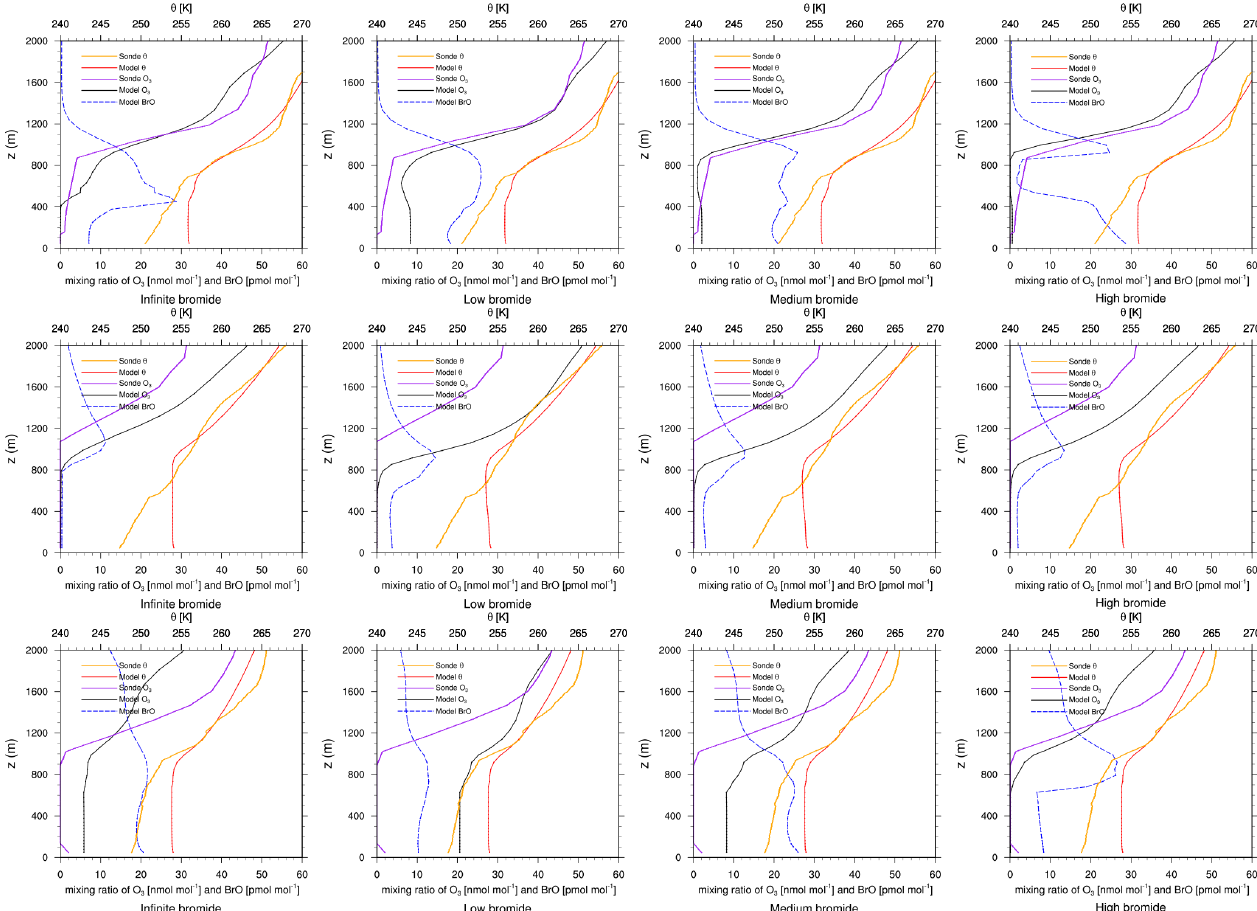
Figure 8. Modeled BrO mixing ratio as well as potential temperature θ and ozone mixing ratios from simulations and from ozone sonde flights against height at Resolute. Columns: infinite FY ice bromide (left), low bromide (left center), medium bromide (right center), high bromide (right). Rows: 4 April 2019 (top), 18 April 2019 (middle), 25 April 2019